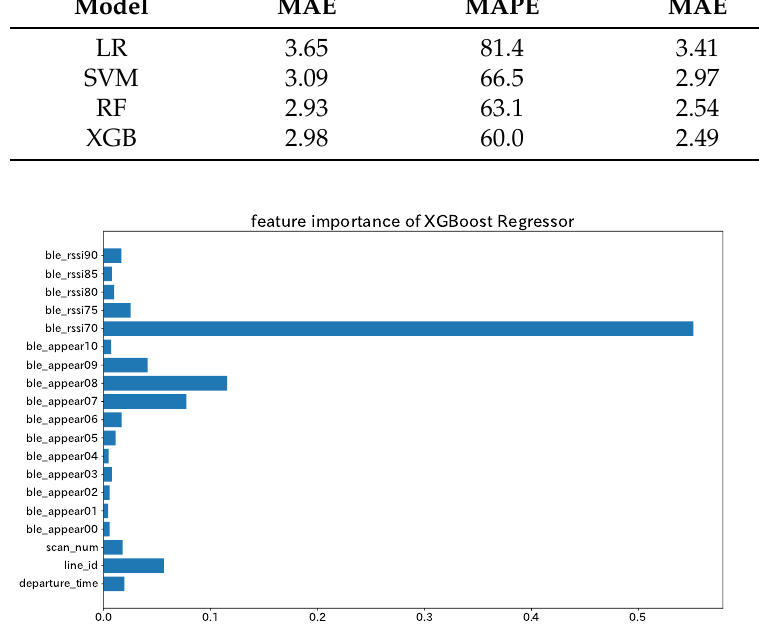
Figure 8. The feature importance of the XGB